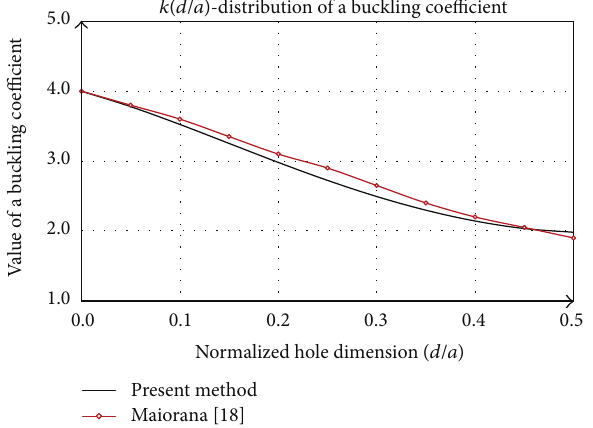
Figure 11: Comparative analysis of buckling coefficient of square plate with a slotted hole (vertical